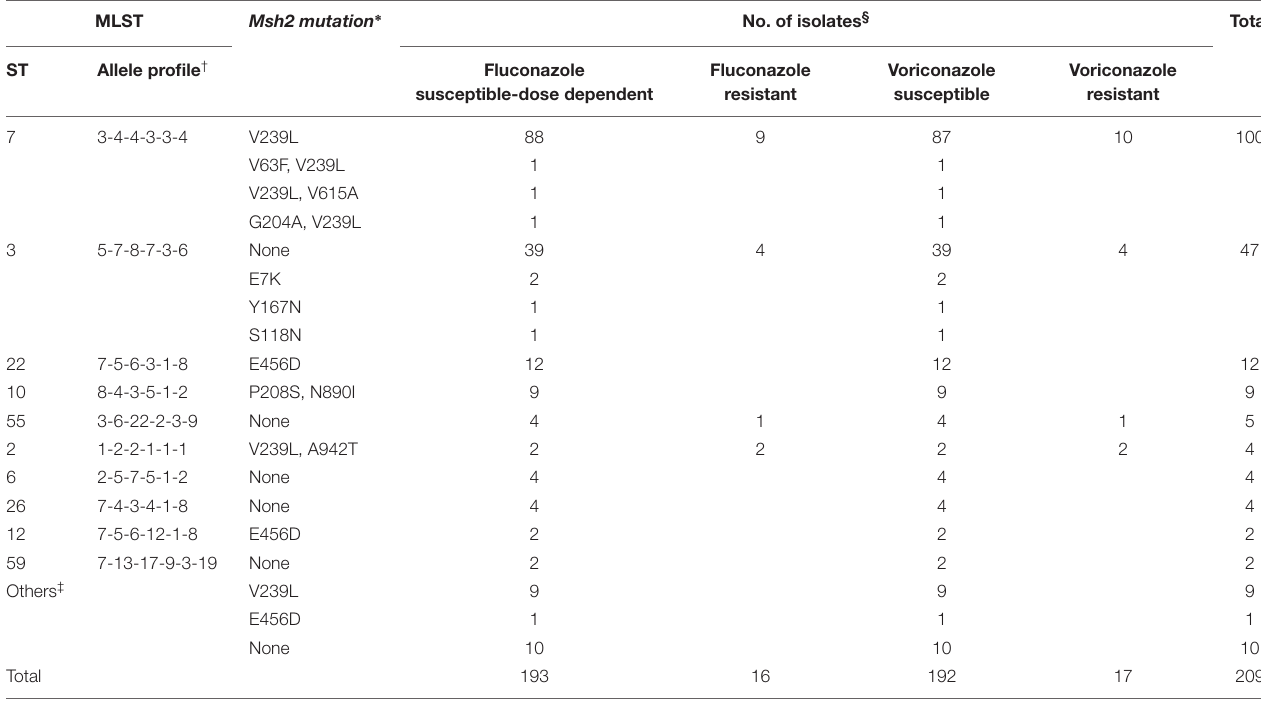
TABLE 2 | Non-synonymous mutations in the mismatch repair gene ( msh2 mutations) in 209 C. glabrata bloodstream isolates according to MLST genotye, fluconazole and voriconazole susceptibilities. MLST Msh2 mutation ∗ No. of isolates §